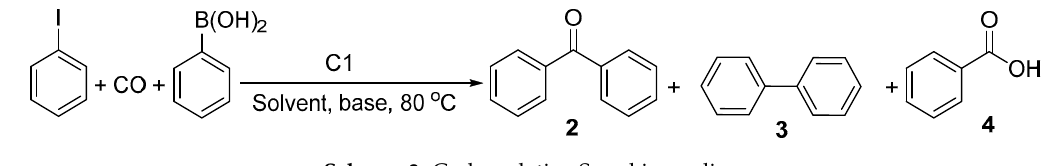
Scheme 3. Carbonylative Suzuki coupling. Table 4. Carbonylative Suzuki coupling catalyzed by C1: solvent, base and CO pressure testing a . Entry Solvent Base